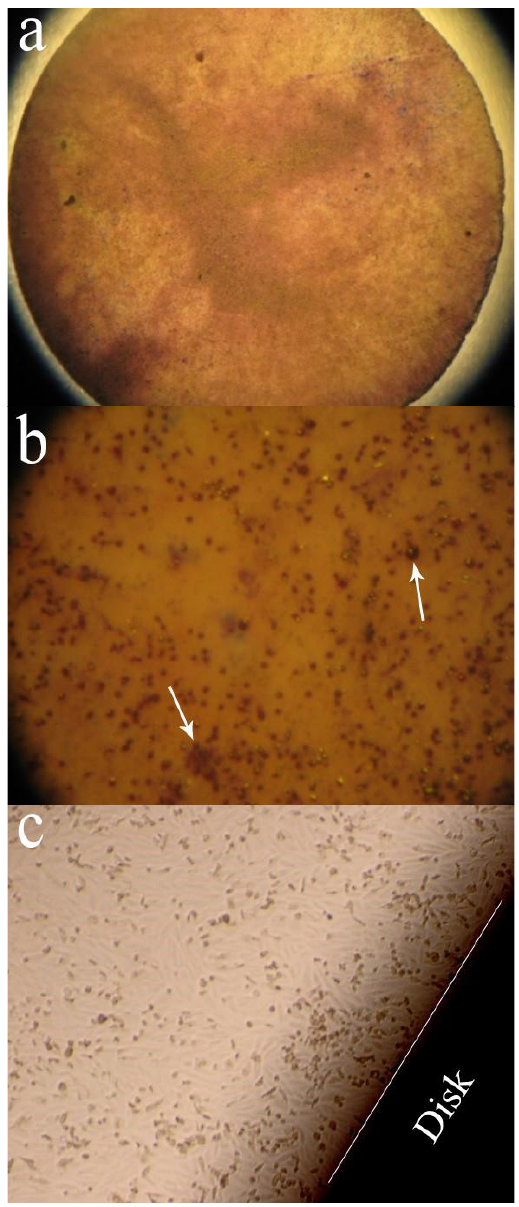
Fig. 3. (a) Shows optical microscopy (OM) images of Saos-2 osteo- blast cells cultured on the disk for 72 h, (b) high magnification and (c) cells cultured in the interface between disk and culture